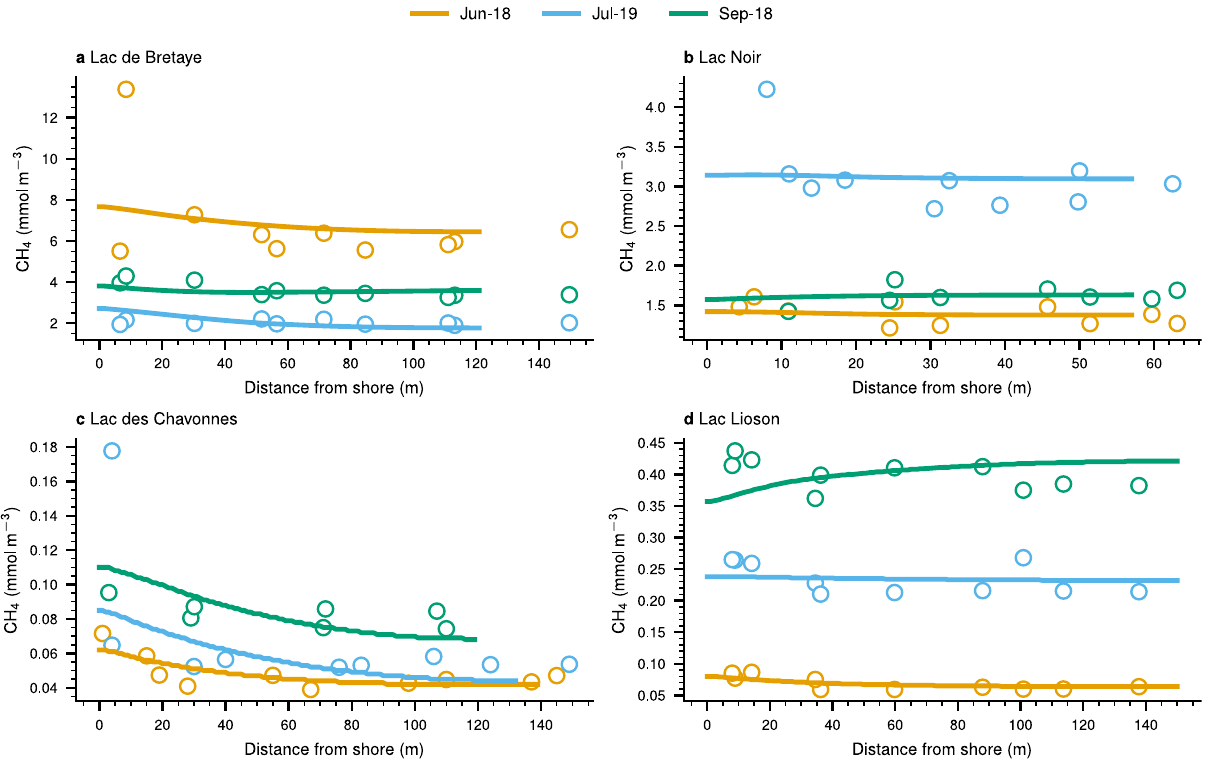
Fig. 2 | Surface CH 4 concentrations along the transects sampled in each lake. a LacdeBretaye, b LacNoir, c LacdesChavonnes,and d LacLioson.Linesrepresent theCH 4 concentrationsimulatedusingthelateraltransportmodelanddotsarethe measured values. Since the lateral transport model assumes that the CH 4